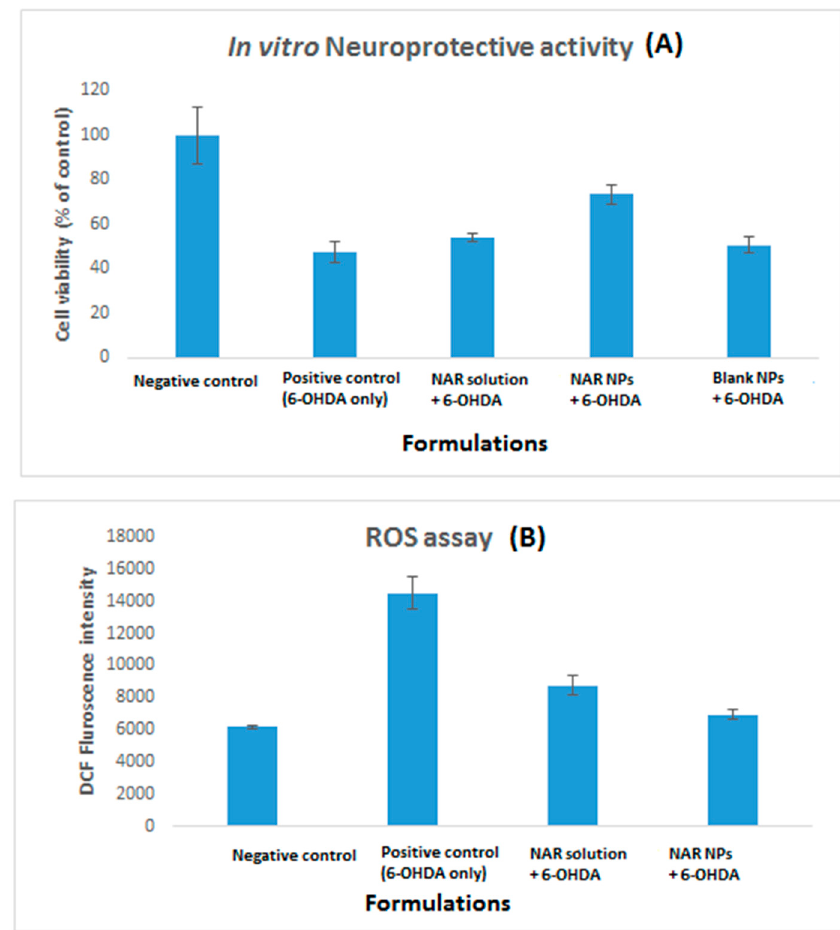
Figure 8. ( A ) Neuroprotective activity and ( B ) reactive oxygen species (ROS) levels of NAR solution, NAR NPs, and placebo NPs were determined in SH-SY5Y cells using MTT assay on 6-OHDA induced neurotoxicity. Negative controls consisted of cells treated with 0.1% dimethylsulfoxide (DMSO) (vehicle control, VC) and cells treated with 6-OHDA alone without prior treatment with NAR solution and NAR NPs are positive control. Data was represented as % cell viability in a bar graph. Viability of control cells was 100%. Data are expressed as mean ± SD ( n = 3). The data were analyzed using one-way ANOVA followed by Tukey’s post hoc test. Percentage of viable cells in each group was compared with VC, p < 0.05 and p < 0.01 indicates a significant and highly significant difference respectively.